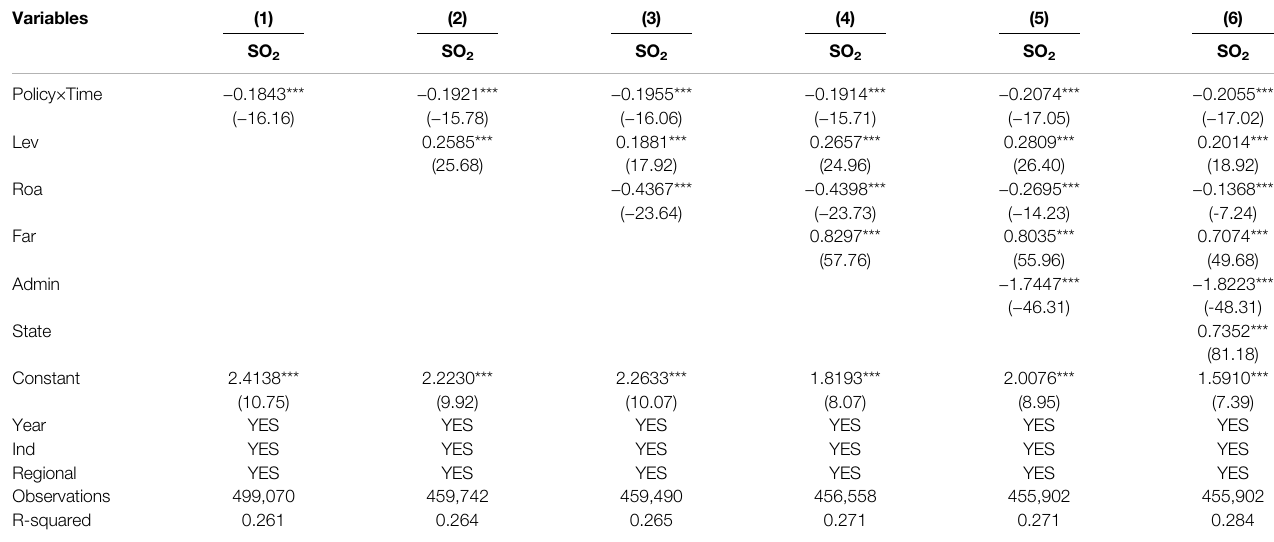
TABLE 3 | Baseline results: the green credit policy and SO 2 emissions.